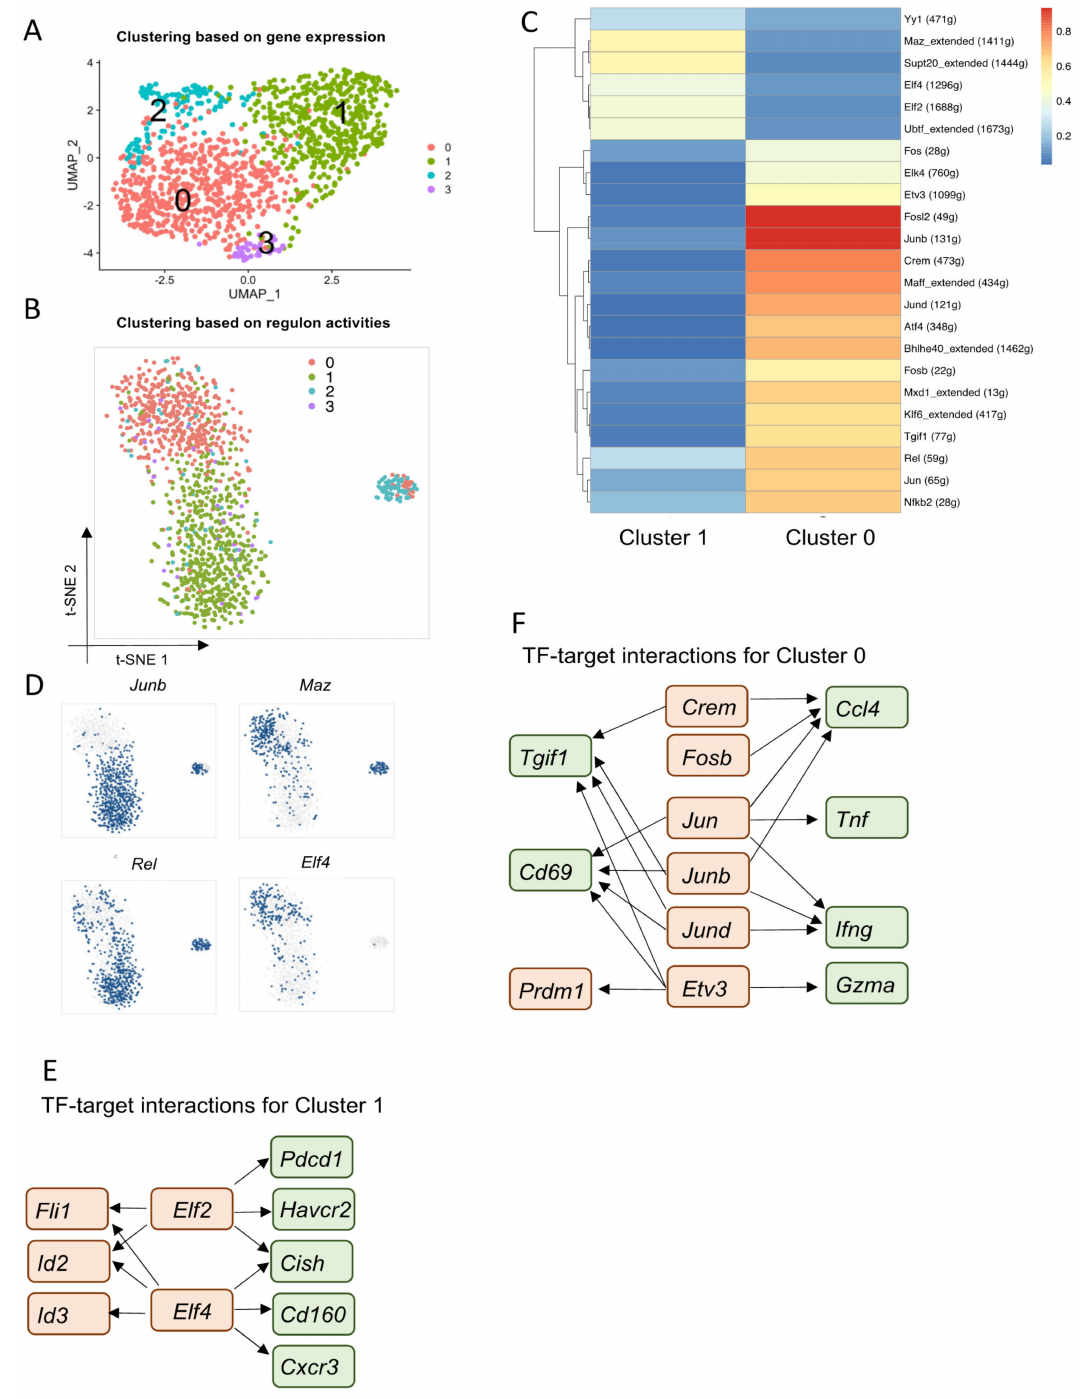
Figure 4. Core regulatory programs that determine heterogeneous TRM populations in siIELs: ( A ) Unsupervised clustering of TRM cells based on gene expression identified four major populations when visualized by UMAP. scRNA-seq data were generated from siIEL GP33 + CD44 + CD8 + cells, 30 days post-LCMV Armstrong infection. ( B ) Unsupervised clustering based on regulon activity separated cells into three major populations when visualized by tSNE. Colors denote the CD8 + T-cell subsets identified by gene expression profiles. ( C ) Heatmap showing the average regulon activity in Clusters 0 and 1. Scale bar denotes SCENIC AUC score. Numbers in parentheses denote the number of co-expressed and direct target genes of each transcription factor. ( D ) t-SNE projections showing binary regulon activity of example regulons for TRM subsets. ( E , F ) Gene regulatory networks showing TF-target interactions for Cluster 1 and Cluster 0. Key TFs are highlighted in red, putative regulated genes are highlighted in